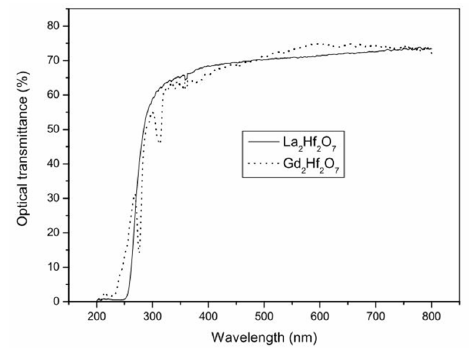
Fig. 5 Transmittance of Ln 2 Hf 2 O 7 (Ln = La, Gd) transparent ceramics sintered at 1850 ℃ for 6 h. Reproduced with permission from Ref. [89], © Chinese Academy of Sciences 2006.